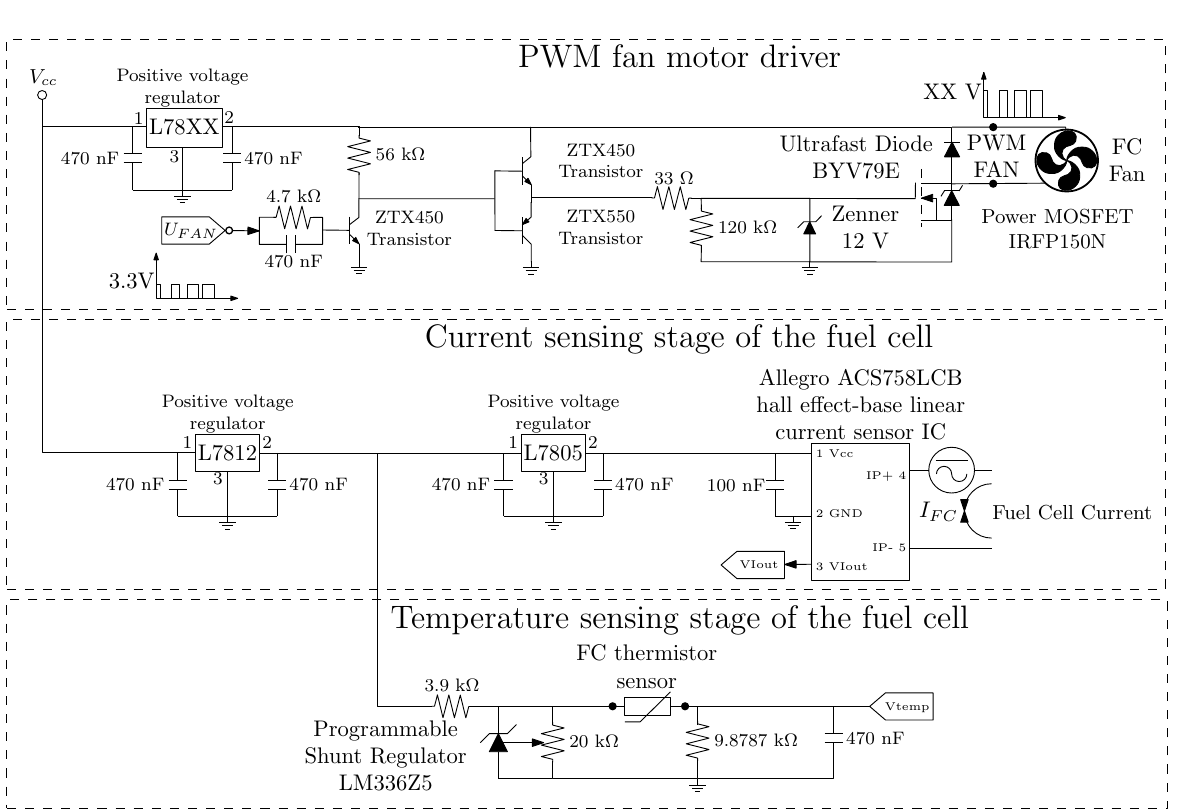
Figure 3. Circuit schematic of the PWM fan driver, current and temperature sensing of the